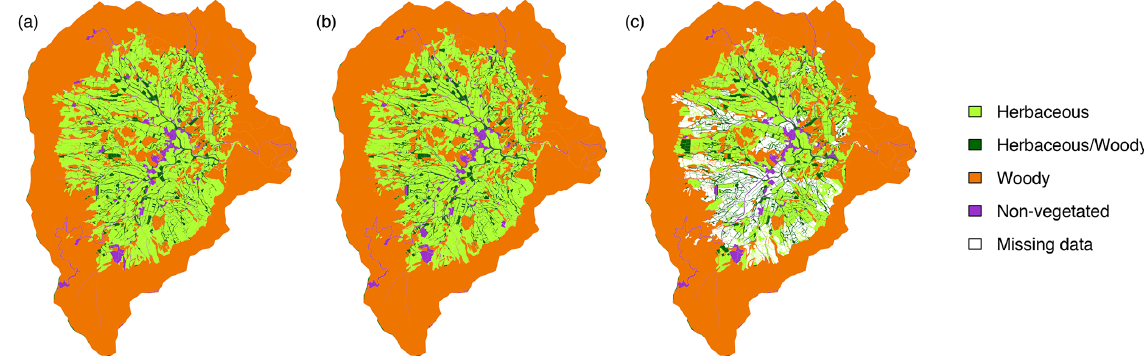
Figure 2. Life form of the vegetation cover according to the FAO-LCCS in (a) 2009, (b) 2010 and (c) 2011.